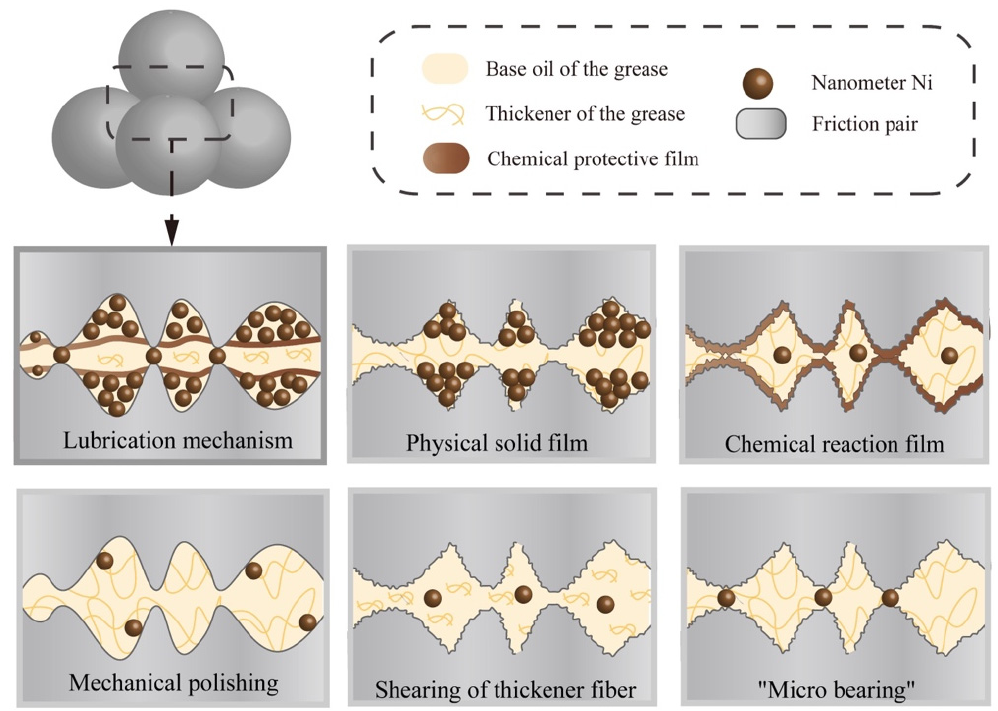
Figure 10. Schematic of the lubrication mechanism of nanometer Ni as an additive in lithium grease.